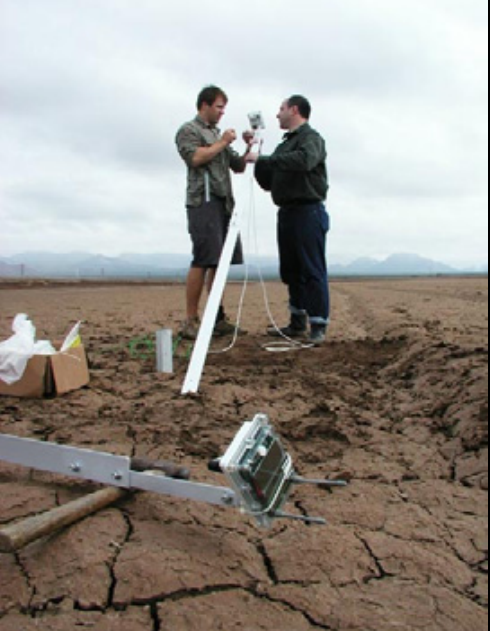
Figure 5. NASA/JPL team members deploy a Sensor Web 3.2 pod in recharge basin. Extended stands allow the pods to stay operational above water during a flooding event. Note polygon patterns in soil, indicative of previous flooding/drying